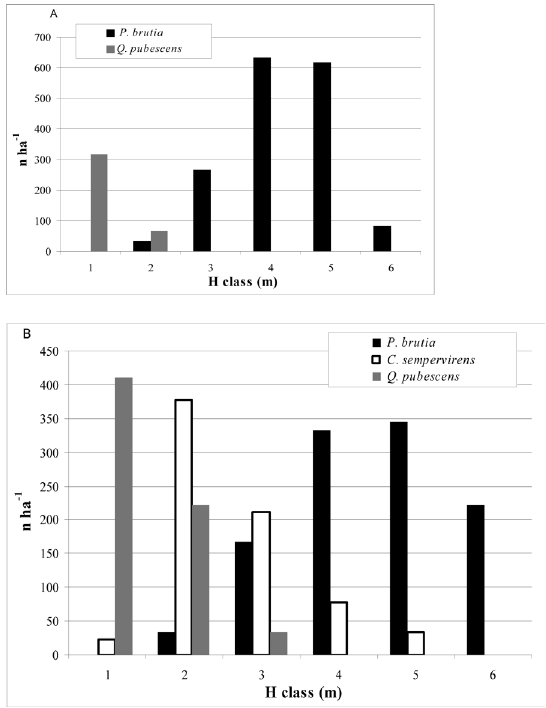
Figure 5. Distribution of height classes of the mixed P. brutia stands on southern (A) and northern aspects (B).